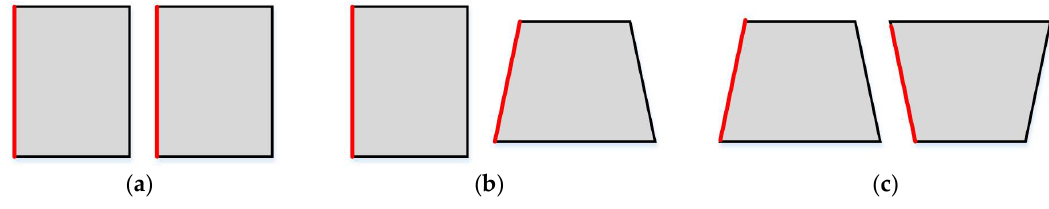
Figure 1. Under ideal circumstances, the imaging situations achieved by stereo cameras of different viewing-angles on a rectangular building structure are as follows: ( a ) the imaging performance of two down-looking cameras; ( b ) the imaging performance of a down-looking camera and a side-looking camera; ( c ) the imaging performance of two side-looking cameras. The red line represents the edge of the building and the line segment to be matched.